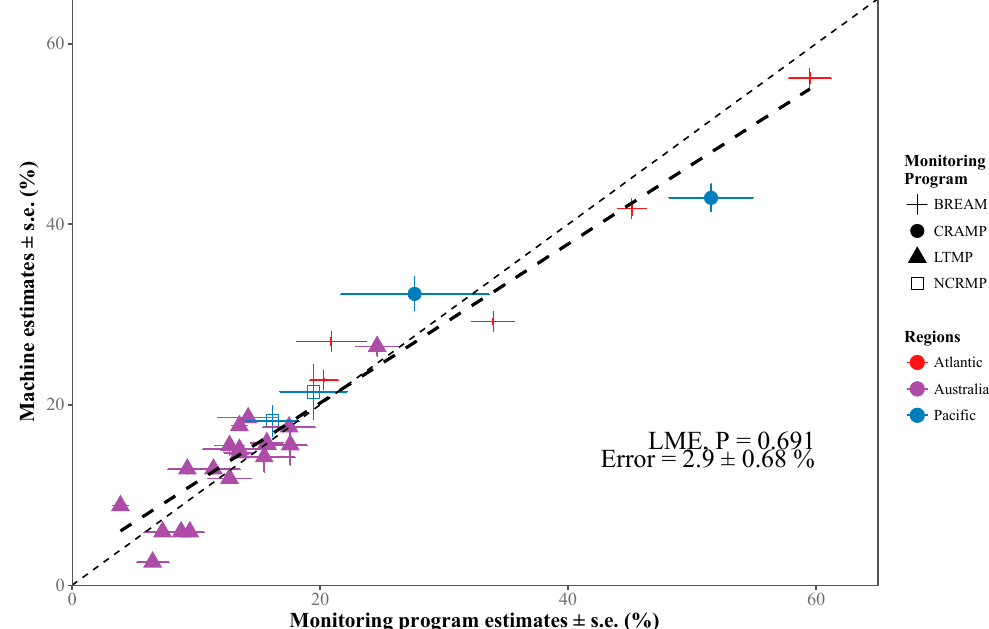
Figure 7. Comparison in coral cover estimates between automated and manual assessments from four major monitoring programs (shapes) across regions (colours). The fine dotted line represents the line where estimations from monitoring programs and machine learning are equal. The thick dotted line and the dark-grey region represent the linear mixed-effect regression (LME) model predictions and standard error intervals, respectively. The model significance of pair-wise comparisons (P) and the average mean absolute error (Error) across monitoring sites is shown in the plot area.